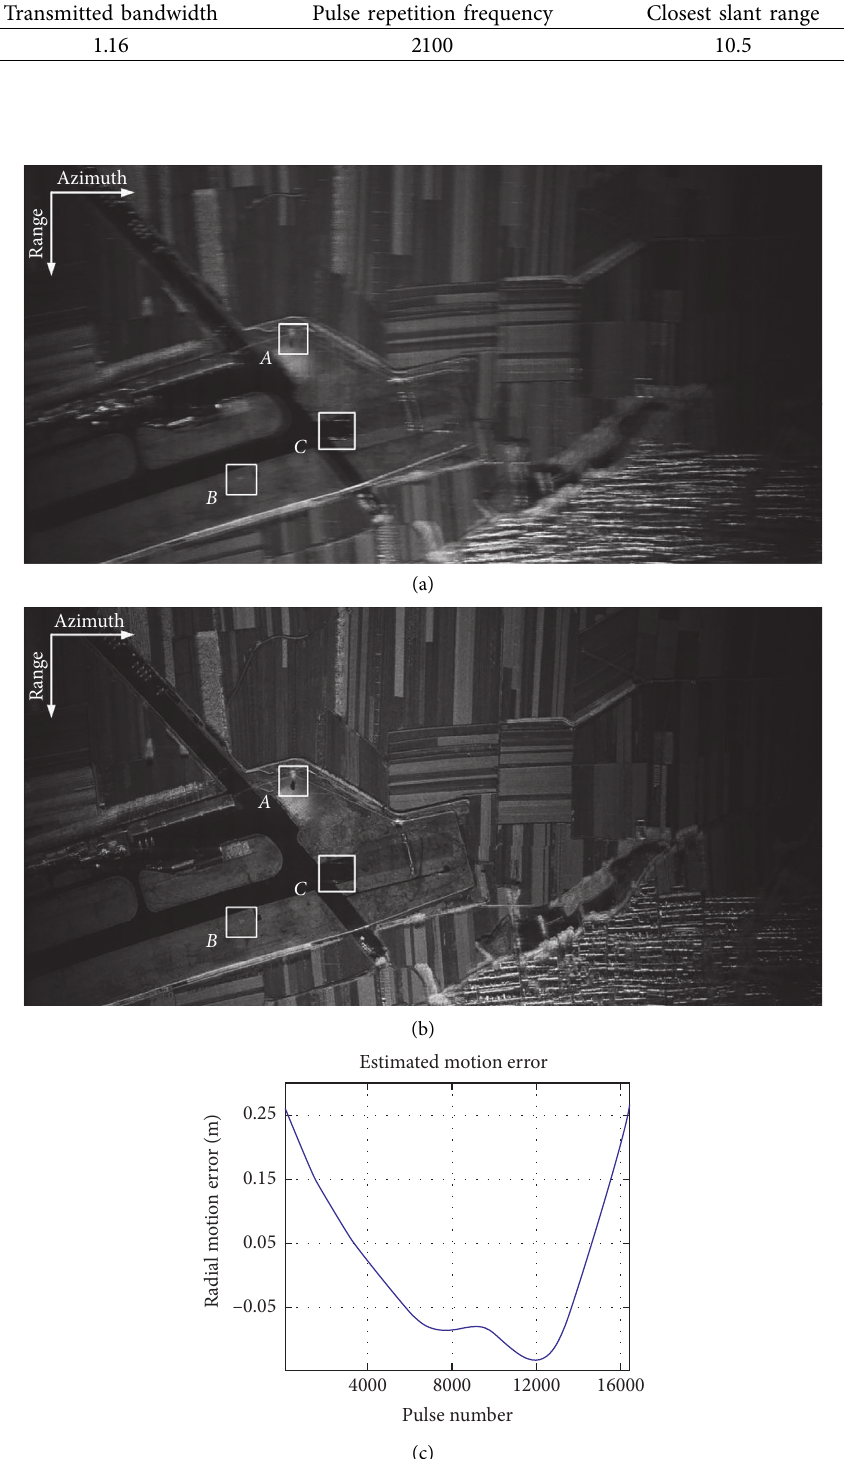
Figure 6: Images formed by the modified FFBP. (a) Uncompensated SAR image; (b) SAR image restored by PGA; (c) radial error extracted form phase error by PGA.